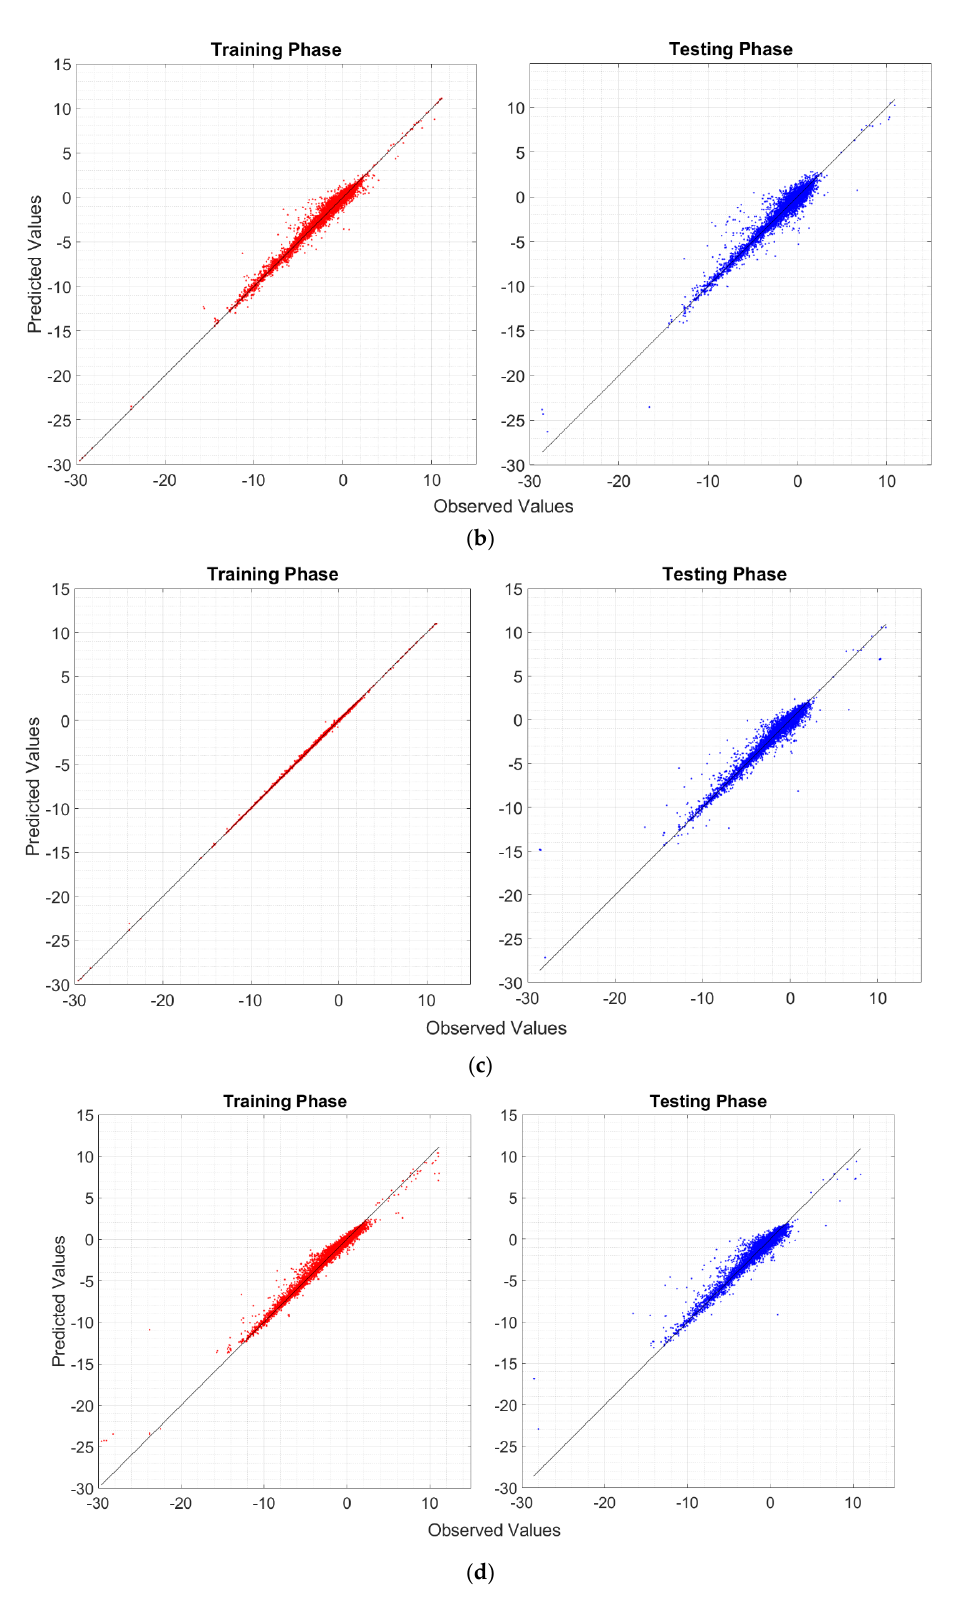
Figure 7. Scatterplots of the training and testing phases: ( a ) Regression Tree (RT); ( b ) SVM; ( c ) BRT; ( d )